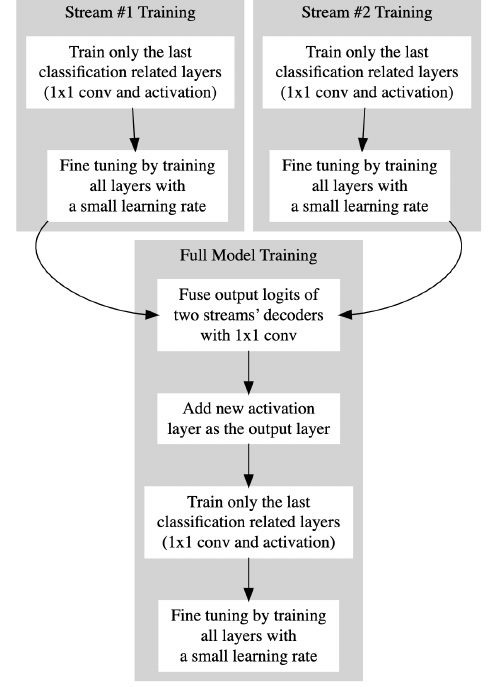
Figure 4. Training